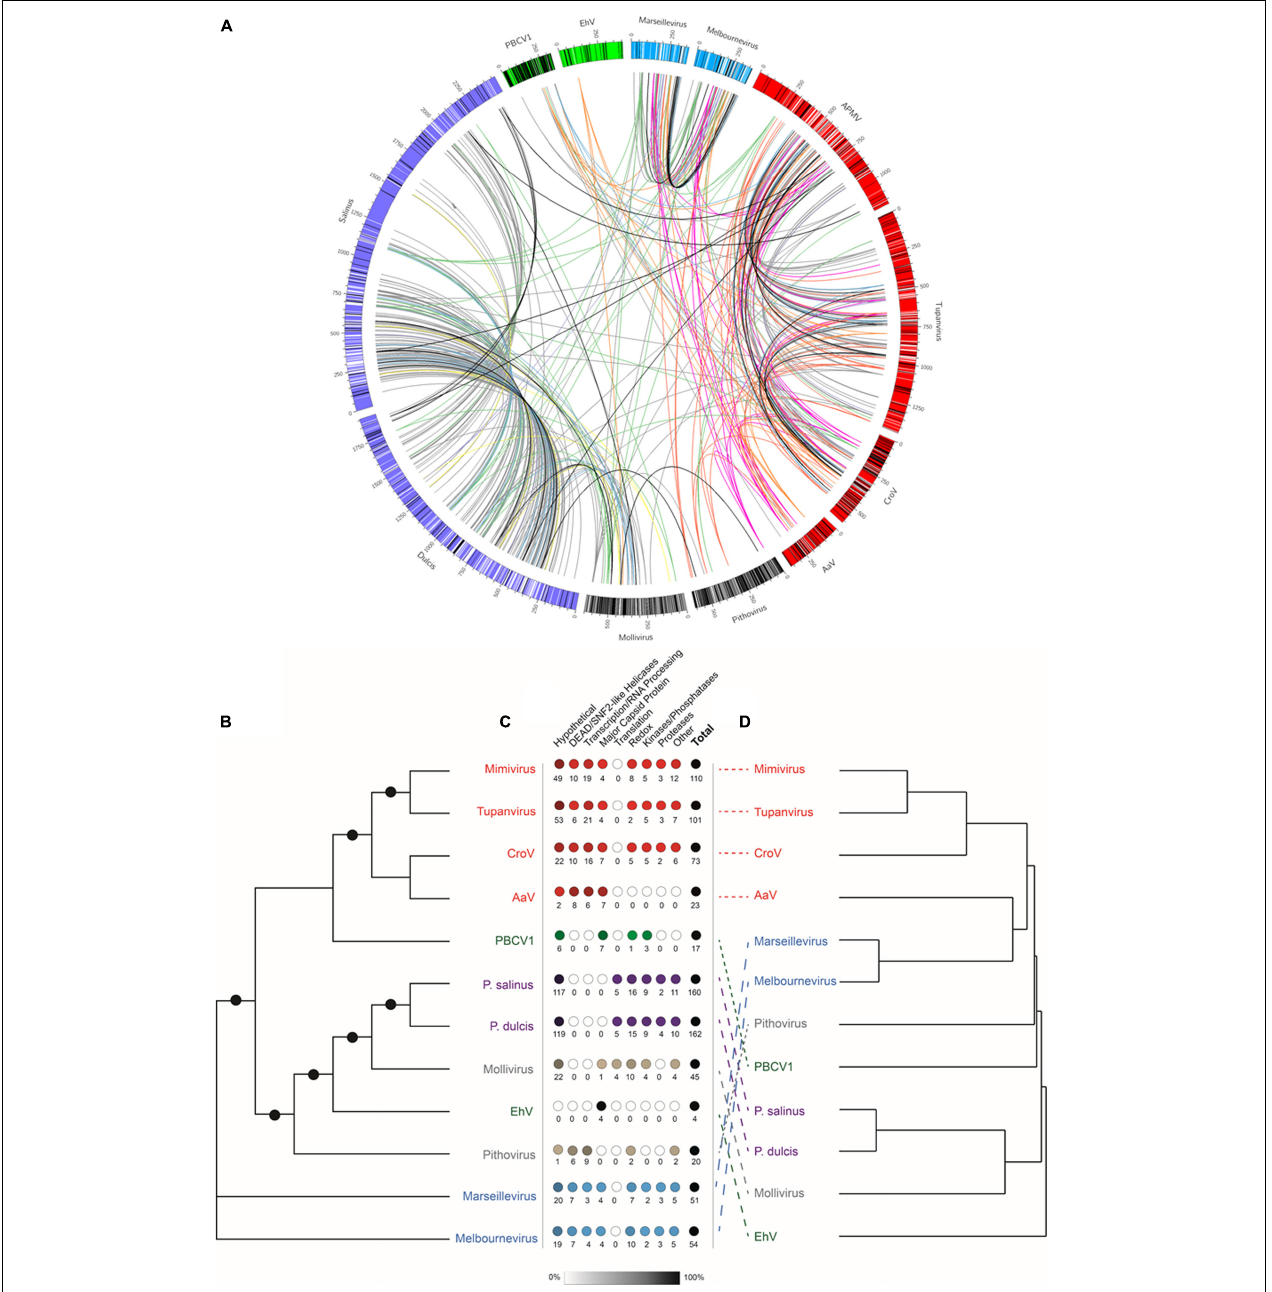
FIGURE 3 | Comparison of packaged proteins between representative viruses. (A) The outer bars are the genomes of each of the representative viruses, where there the color is based on the viral family it belongs to: red = Mimiviridae , green = Phycodnaviridae , blue = Marseilleviridae , and purple = Pandoraviridae . The black lines represent the location of the genes encoding proteins packaged in the particle that do not have reciprocal best BLAST hits to any of the other representatives, while white bare lines represent the location of the genes encoding proteins packaged in the particle that do have reciprocal best BLAST hits to any of the other representatives. The lines between viruses are connecting reciprocal best BLAST hit pairs with their color being based on the classification of the NCVOG category ( Supplementary Table 3 ). The colors are as follows: uncharacterized pairs = gray, DEAD/SNF2-like helicases = pink, Redox = green, transcription/RNA processing = red, translation = yellow, capsid proteins = orange, proteases = purple, kinases/phosphatases = blue, other = black. (B) Unrooted maximum likelihood DNA Polymerase B (PolB) phylogenetic tree. Node support (aLRT-SH statistic) > 50% are shown as dark circles. (C) Number of reciprocal best BLAST hit pairs found within each virus proteome by type of NCVOG category ( Supplementary Table 3 ). Numbers below the circles indicate the number of reciprocal best BLAST hit pairs. Shading of the circles represent the percentage of the total number of reciprocal best BLAST hit pairs. (D) Hierarchical clustering of resemblance based on Bray–Curtis similarity of presence or absence of reciprocal best BLAST hit pairs for all proteins found within the representative particle proteomes. The colors of the virus names indicate viral families with more than one representative: red = Mimiviridae , green = Phycodnaviridae , blue = Marseilleviridae , and purple = Pandoraviridae